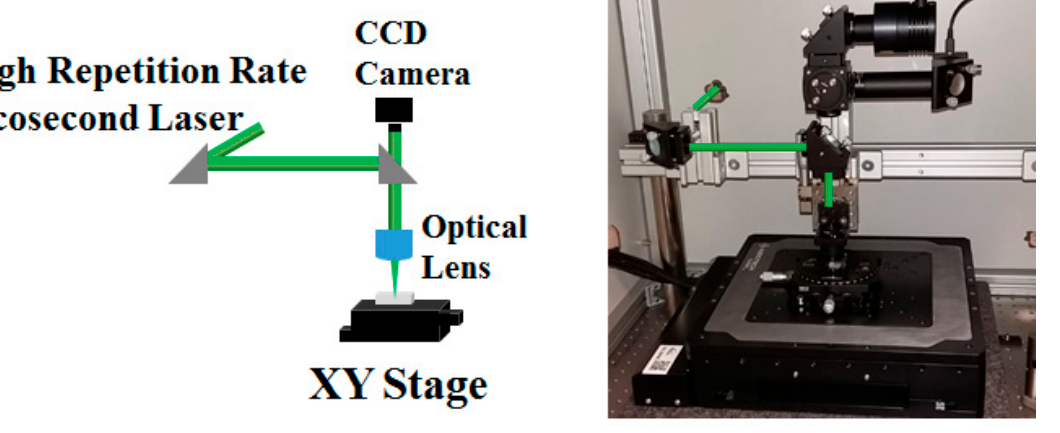
Figure 1. Scheme and photo of the workstation used for high repetition rate ps laser irradiation of Foturan glass.